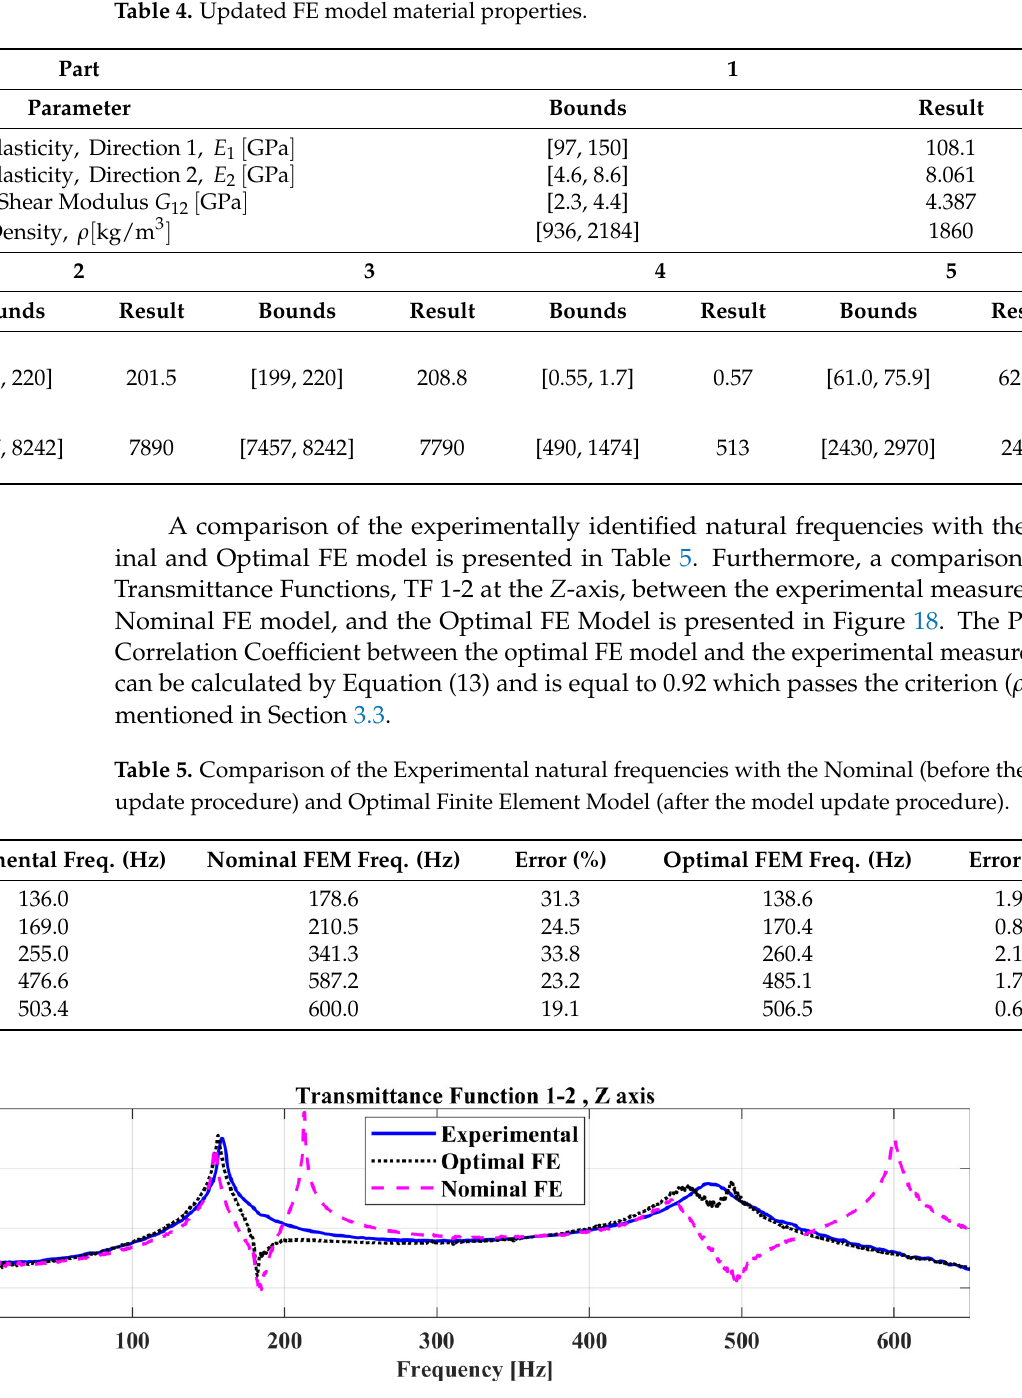
Figure 18. Comparison of the Transmittance Function 1-2 between the experimental measurements, the nominal FE Model and the Optimal FE Model.